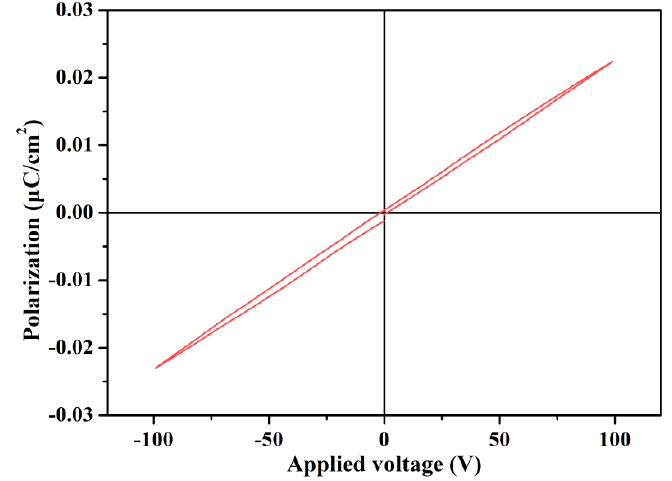
Figure 8. P-V loop of SCPEN film.